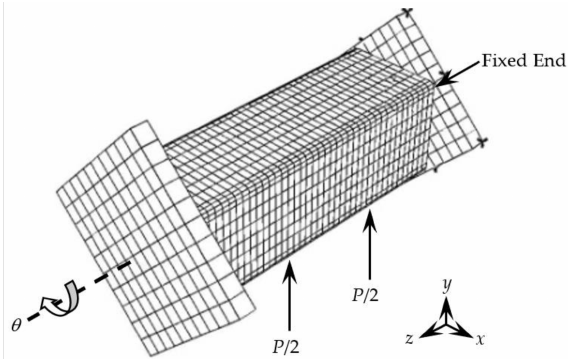
Figure 8. The boundary conditions of finite element simulation of